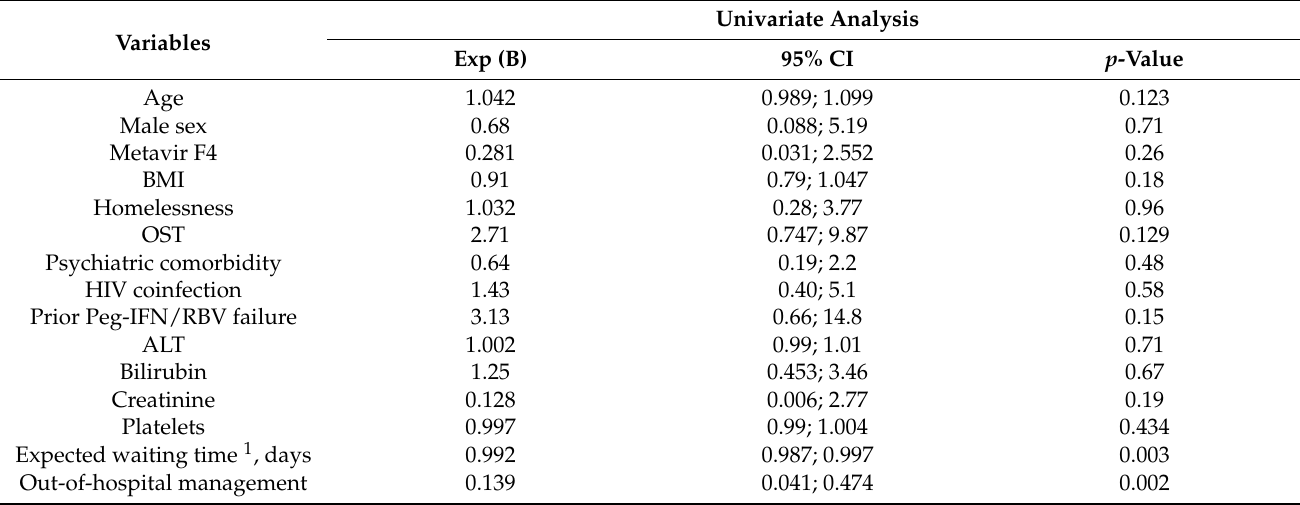
Table 4. Univariate analysis of factors associated to the retention in